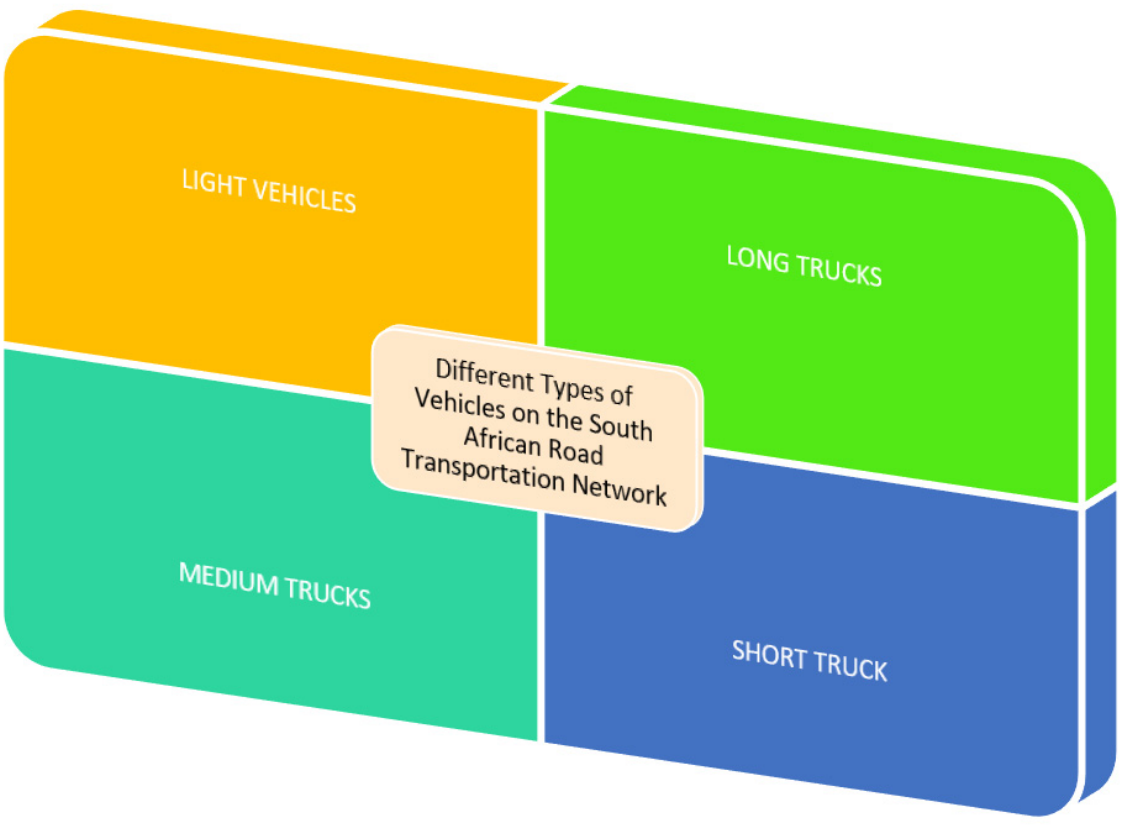
Figure 3. The different categories of vehicles used in this study.